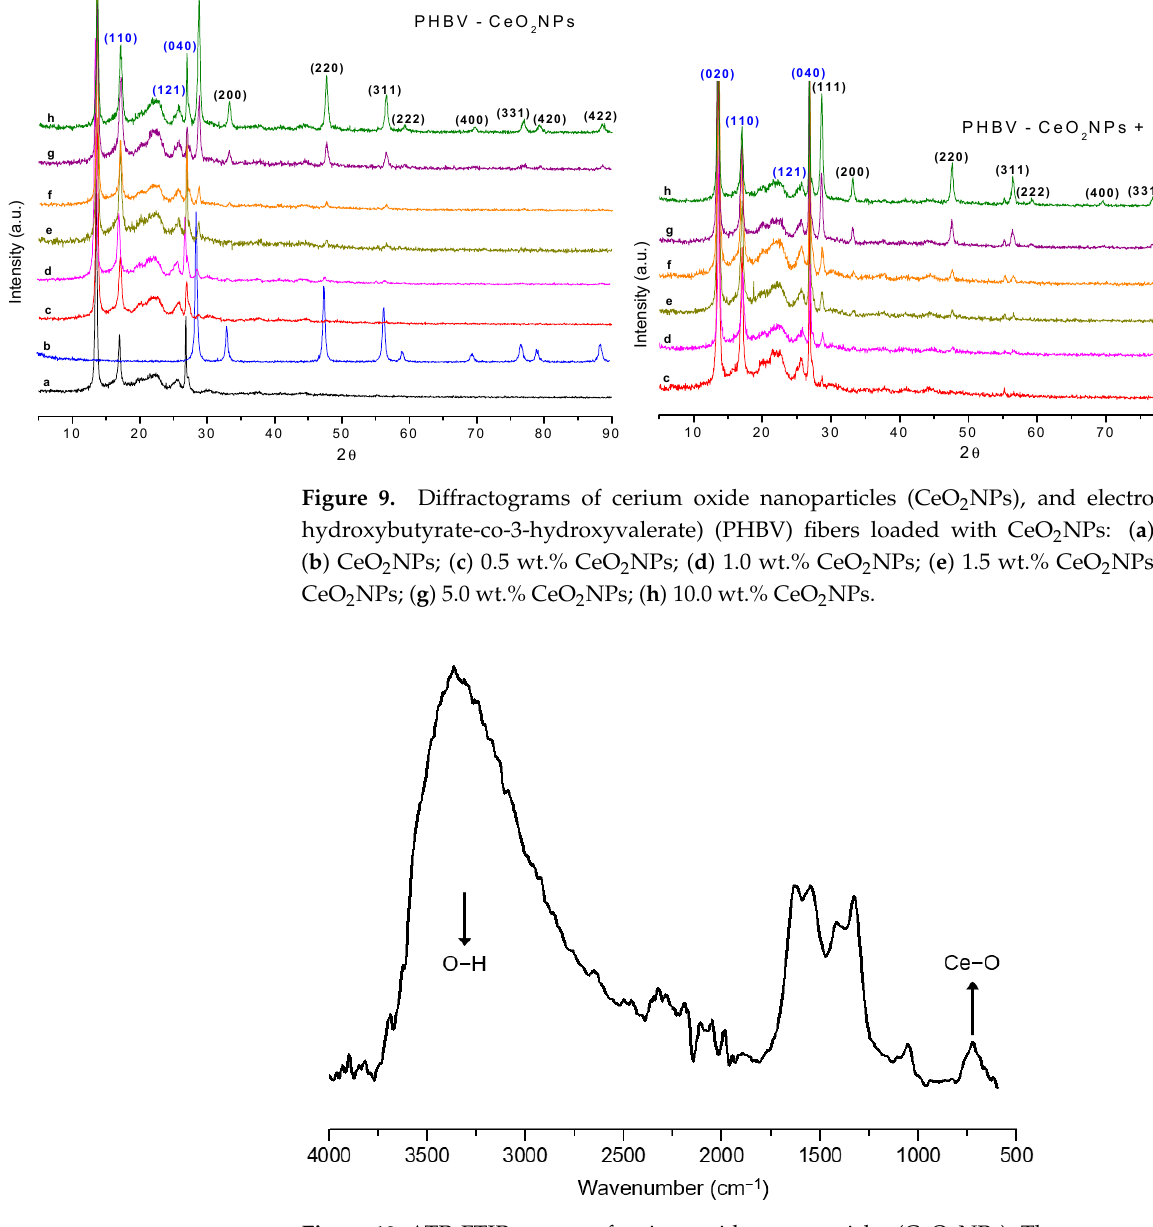
Figure 11. ATR-FTIR spectra of electrospun poly(3-hydroxybutyrate-co-3-hydroxyvalerate) (PHBV) fibers loaded with cerium oxide nanoparticles (CeO 2 NPs): ( a ) neat PHBV; ( b ) 0.5 wt.% CeO 2 NPs; ( c ) 0.5 wt.% CeO 2 NPs + CTAB; ( d ) 1.0 wt.% CeO 2 NPs; ( e ) 1.0 wt.% CeO 2 NPs + CTAB; ( f ) 1.5 wt.% CeO 2 NPs; ( g ) 1.5 wt.% CeO 2 NPs + CTAB; ( h ) 2.0 wt.% CeO 2 NPs; ( i ) 2.0 wt.% CeO 2 NPs + CTAB; ( j ) 5.0 wt.% CeO 2 NPs; ( k ) 5.0 wt.% CeO 2 NPs + CTAB; ( l ) 10.0 wt.% CeO 2 NPs; ( m ) 10.0 wt.% CeO 2 NPs + CTAB. The spectra were acquired between 4000 and 600 cm − 1 wavenumber. 3.5. Thermal Properties 3.5.1. Differential Scanning Calorimetry (DSC) of the Electrospun Fibers DSC was performed to discern the main thermal events of electrospun PHBV fibers containing CeO 2 NPs and CTAB. Results are shown in Table 2. In the first heating, the pure 4000